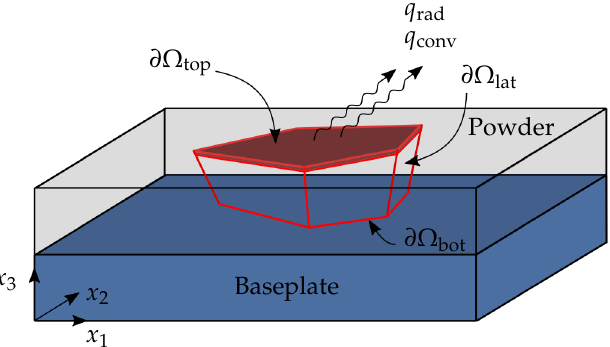
Figure 1. Schematic illustration of a body Ω being fabricated during the LPBF process. The topmost crimson colored region signifies the newly deposited layer. The body is attached to the baseplate at the bottom surface ∂ Ω bot while a laser scans the top surface ∂ Ω top . The part-powder interface is denoted as the lateral surface ∂ Ω lat . Thermal losses due to convection and radiation are shown as q conv and q rad ,